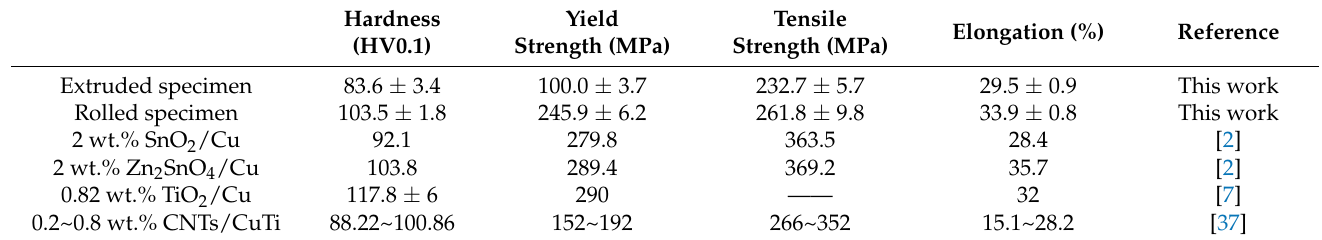
Table 2. Mechanical properties of CdMoO 4 -reinforced Cu-based composites.